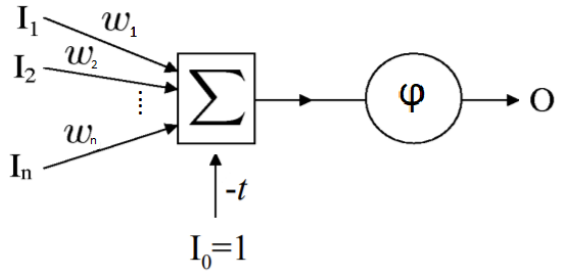
Figure 1. Neuron.